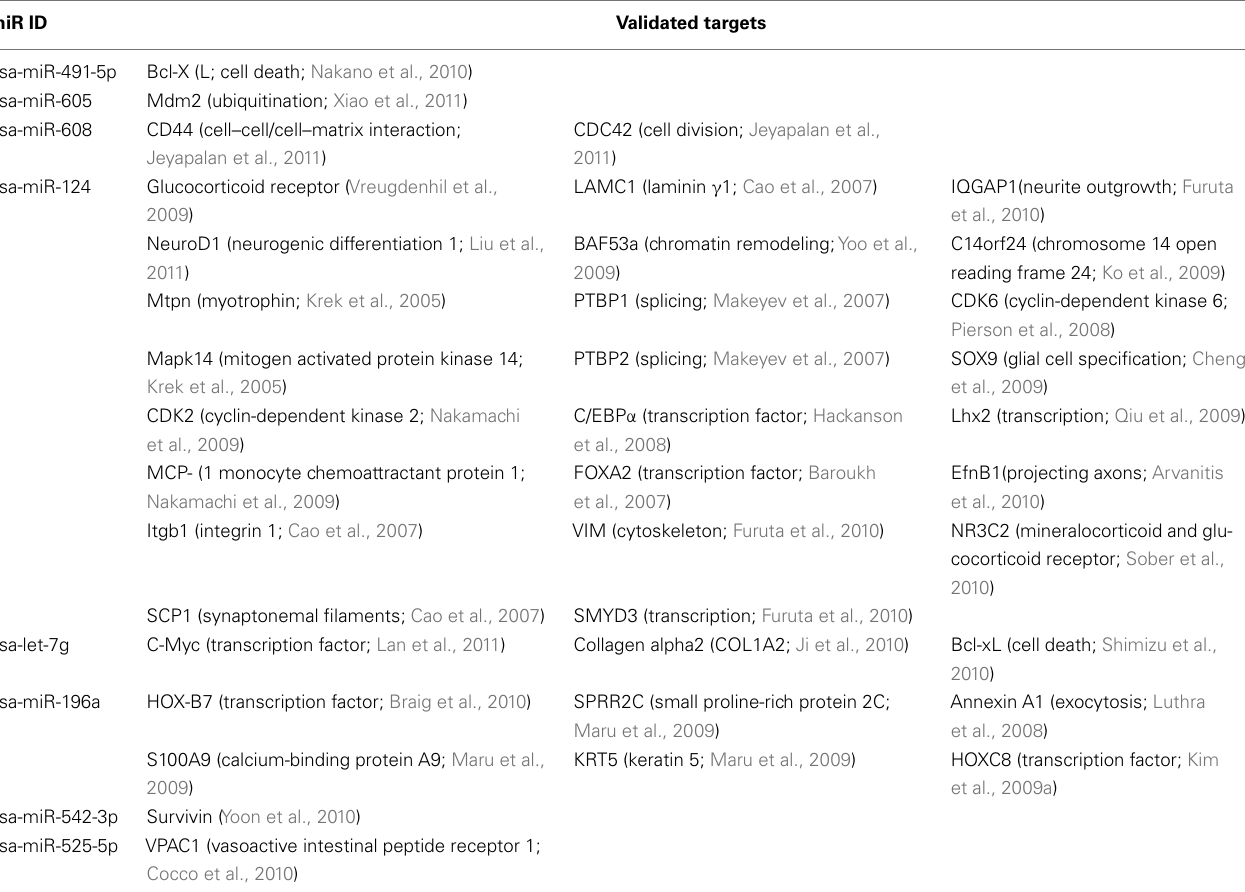
TableA1 |Additional targets ofAChE-S targeting